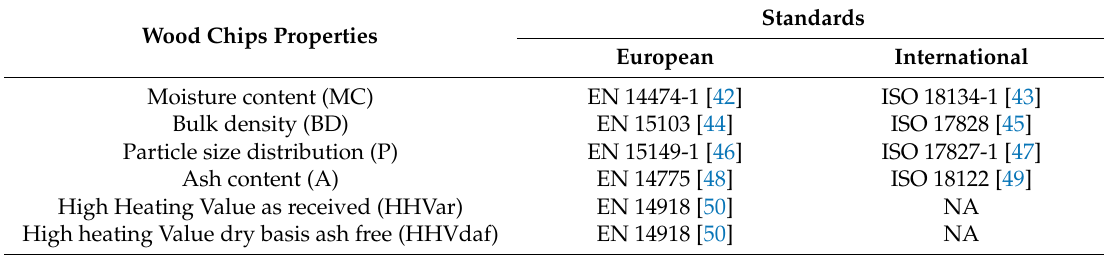
Table 1 lists the standard methodologies for determining the physical properties of wood chips. Table 1. Standard methodologies used to assess physical characteristics of wood chips (NA = Not Applicable).